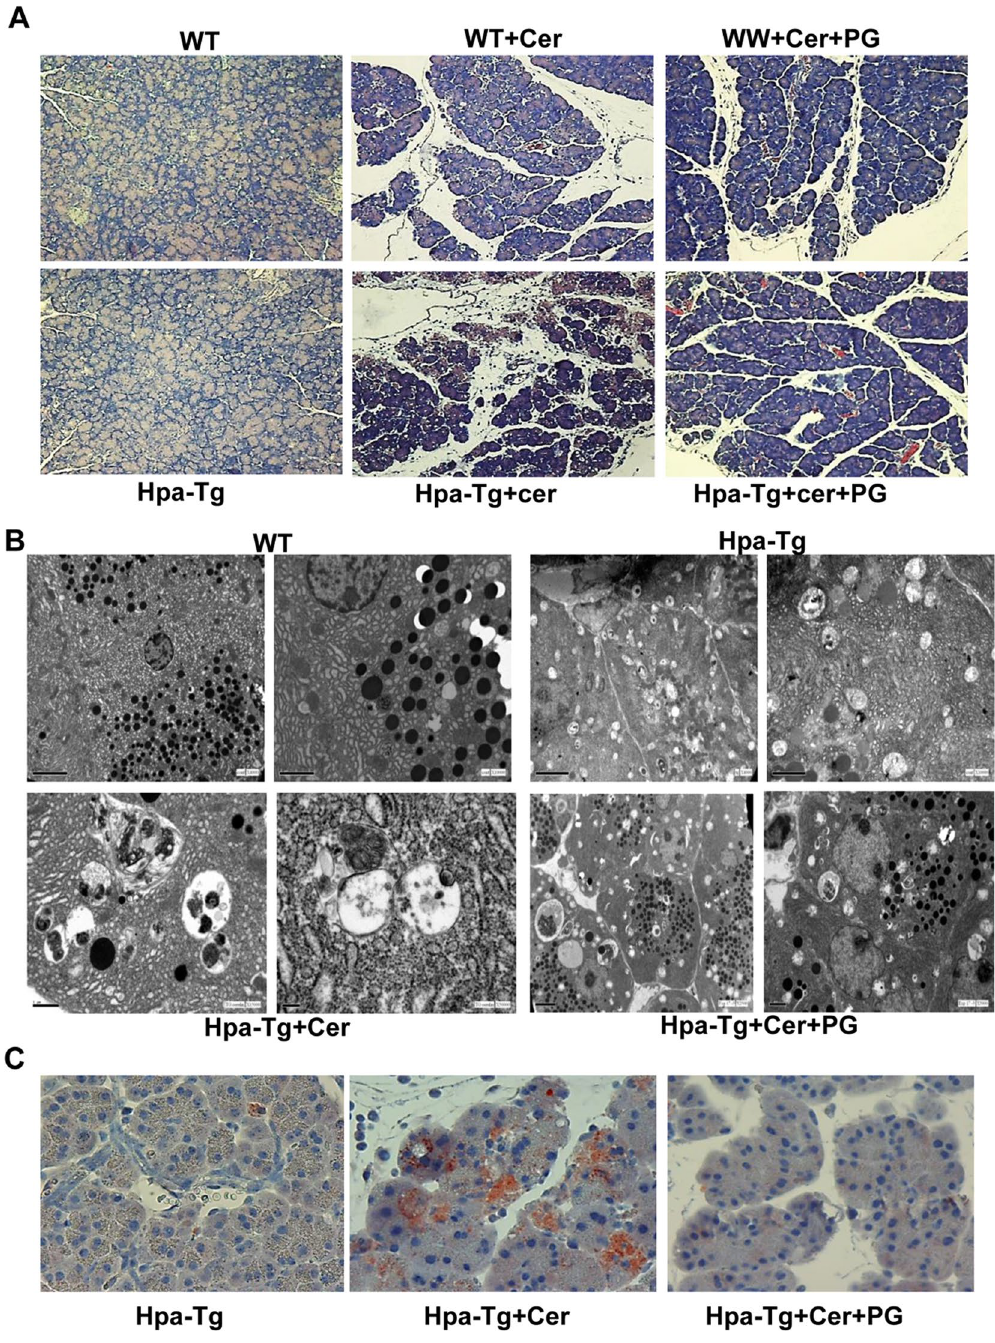
Figure 2. Histological analyses. ( A ) H&E staining. WT and Hpa-Tg mice were injected with saline (left panels) or cerulein in the absence (middle panels) or presence (right panels) of PG545 pretreatment. Pancreas tissues were collected 24 h thereafter, and 5 micron sections from formalin-fixed, paraffin-embedded samples were stained for H&E ( A ). Shown are representative photomicrographs at 10x original magnification. Corresponding pancreas tissues were processed for electron microscopy as described under ‘Materials and Methods’ ( B ). Note, increased autophagy in pancreatic acinar cells of Hpa-Tg vs. WT mice; Autophagy is further enhanced by cerulein, but restored by PG545 (cerulein + PG). Induction of AP resulted in dilatation of RER, mitochondrial swelling and large autophagosomes. Pancreatic tissue from mice treated with PG545 exhibited nearly normal ultrastructural appearance. Shown are representative micrographs at x8000, x10,000 and x12,500 original magnification. ( C ) LC-3 immunostaining. Hpa-Tg mice were injected with saline (left) or cerulein in the absence (middle) or presence (right) of PG545 pretreatment. Pancreas tissues were collected 24 h thereafter, and 5 micron sections from formalin-fixed, paraffin-embedded samples were stained for LC-3 (marker of autophagy). Shown are representative photomicrographs at original magnification of x40. Note that LC-3 staining resembles the patchy pattern of heparanase staining (Fig.